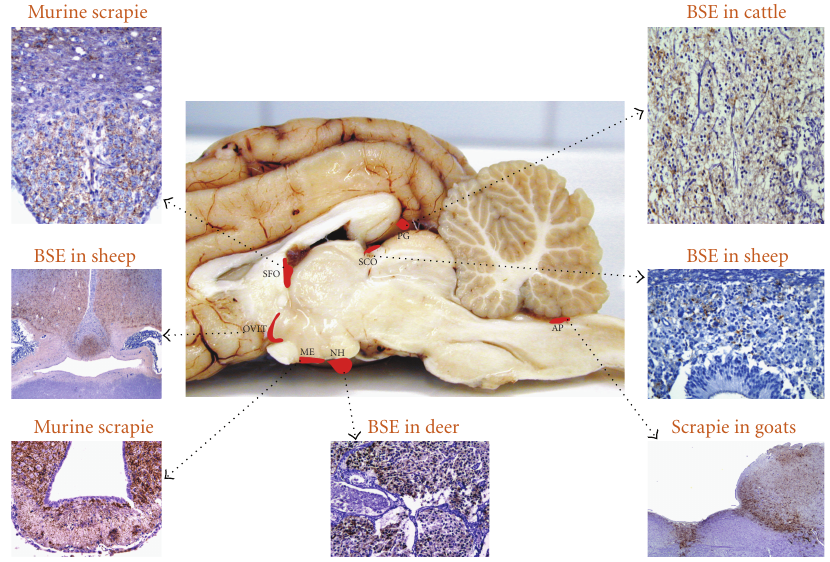
Figure 7: PrP d accumulation within CVOs in clinically a ff ected animals with di ff erent TSE strains. AP, area postrema; PG, pineal gland; ME, median eminence; SCO, subcommisural organ; OVLT, organum vasculosum of lamina terminalis; SFO, subfornical organ; NH,